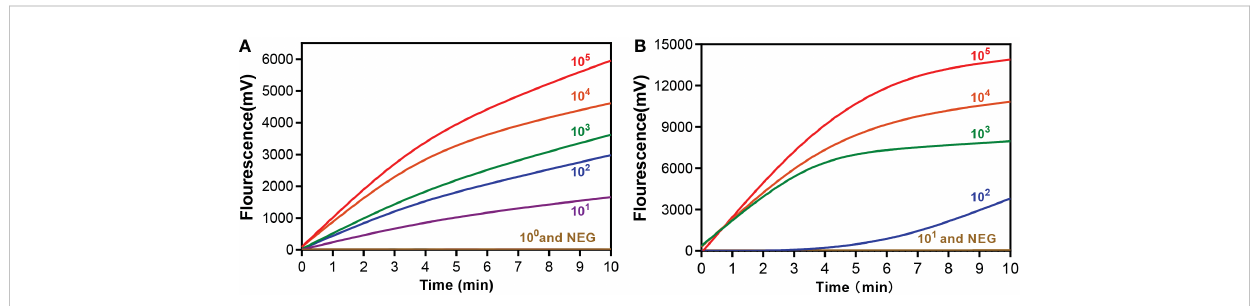
FIGURE 3 Sensitivity of the RAA assay for (A) A27L and (B) F3L gene of mpox virus detection. A serial dilution of the pseudovirus was used ranging from 10 5 to 10 0 copies/reaction. A negative control (replace the pseudovirus with ddH 2 O) was also assayed.